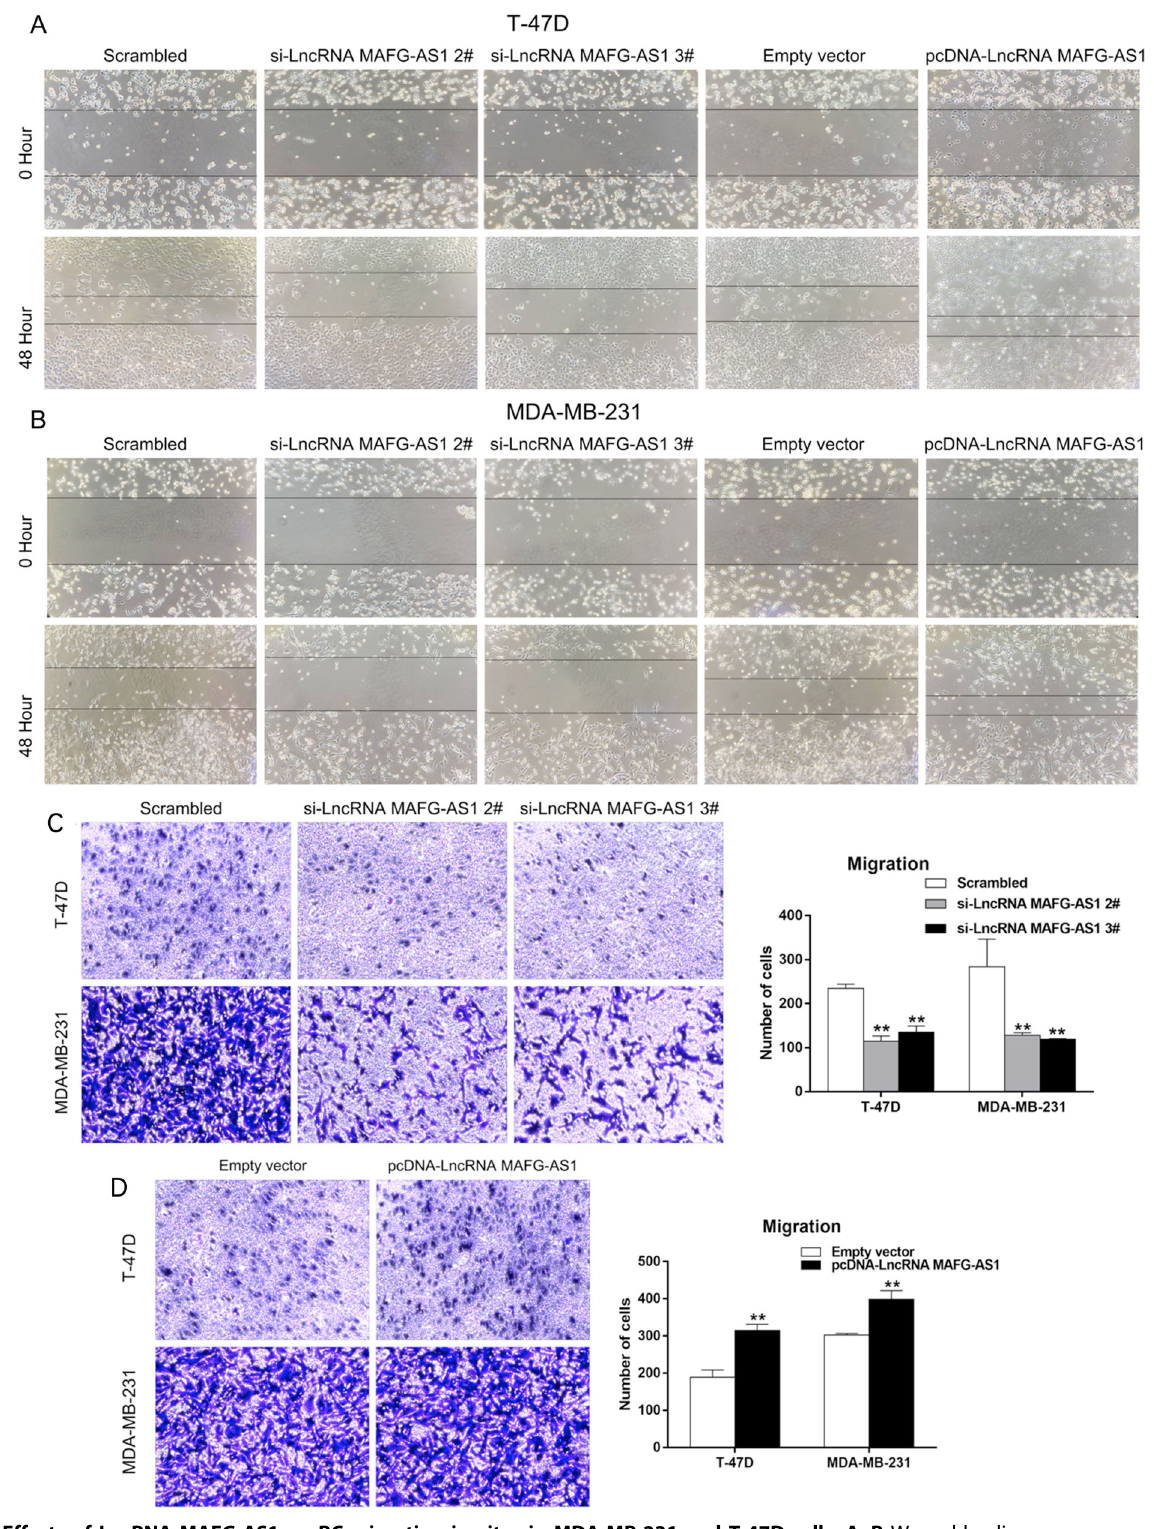
Fig. 4 Effects of LncRNA MAFG-AS1 on BC migration in vitro in MDA-MB-231 and T-47D cells. A , B Wound-healing assays were used to investigate the migratory ability of BC cells. C , D Transwell migration assays were used to investigate the changes in migratory abilities of BC cells. * P < 0.05 and ** P <